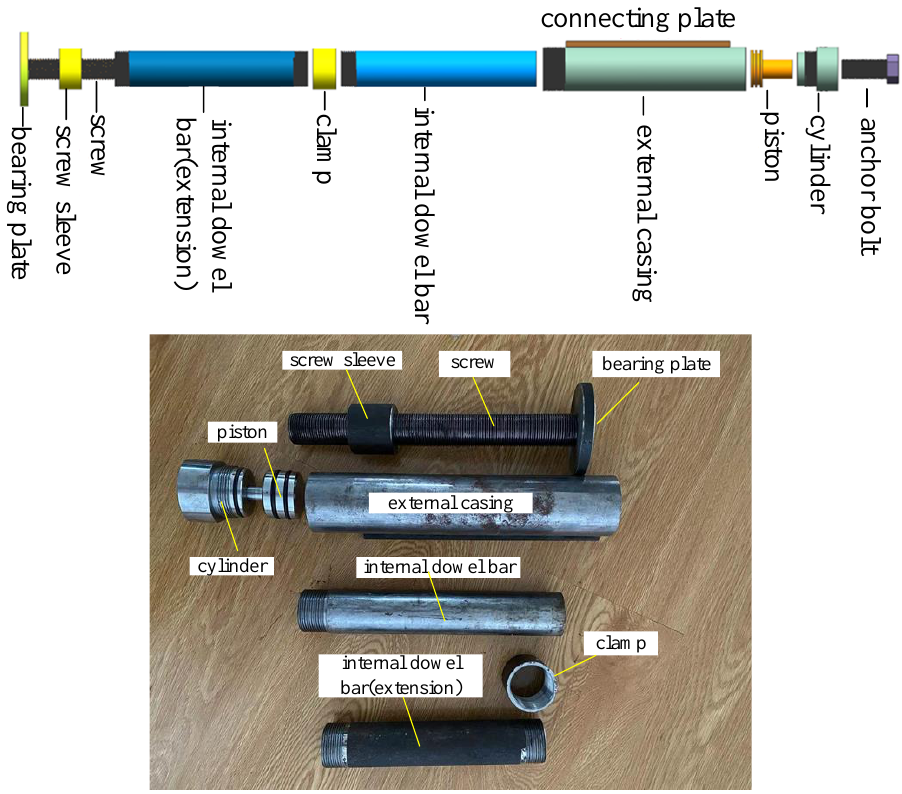
Figure 10. Assembly drawing of load adjusting unit.